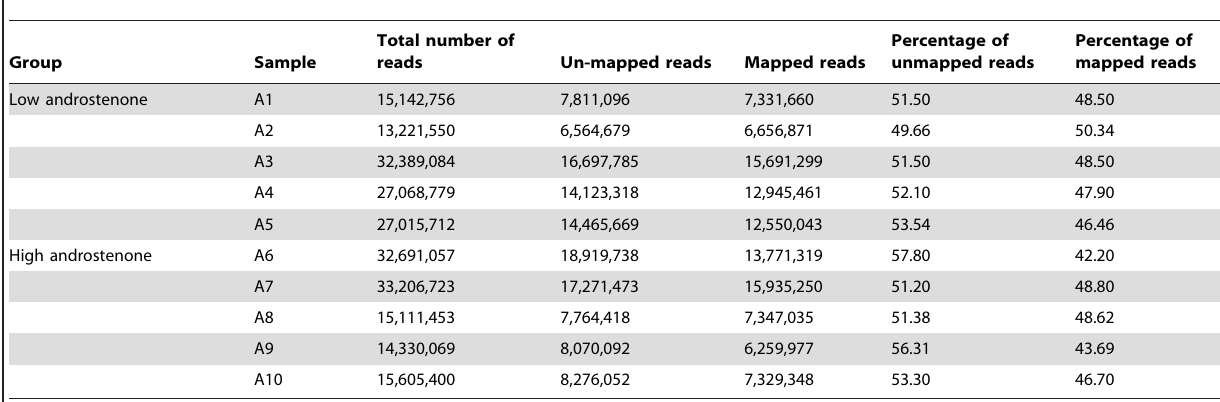
Table 1. Summary of sequence read alignments to reference genome in testis samples.